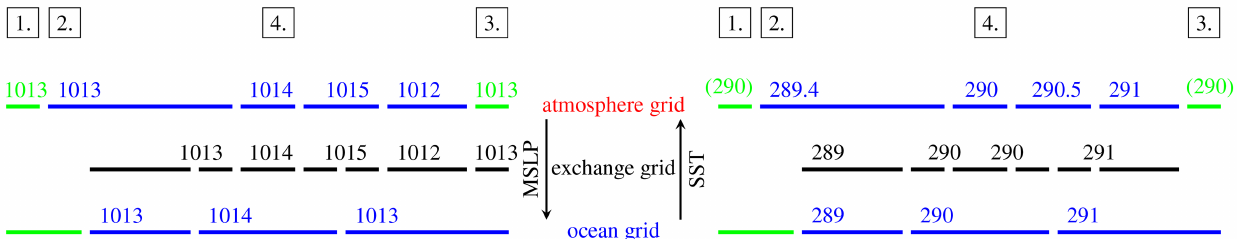
Figure 6. Schematic representation of the regridding between ICON and GETM. In the atmosphere and ocean grids active ocean cells are coloured in blue and land cells in green. As shown for the transfer of mean sea level pressure (MSLP in hPa) and sea surface temperature (SST in K), the exchange grid can consist of different cells for each direction. The four possible combinations of land/ocean masks are indicated. On land (cases 1 and 3) an ICON-internal SST (here 290K) is used. This ICON-internal SST is also considered for fractions of ocean cells not covered by GETM ocean cells (case